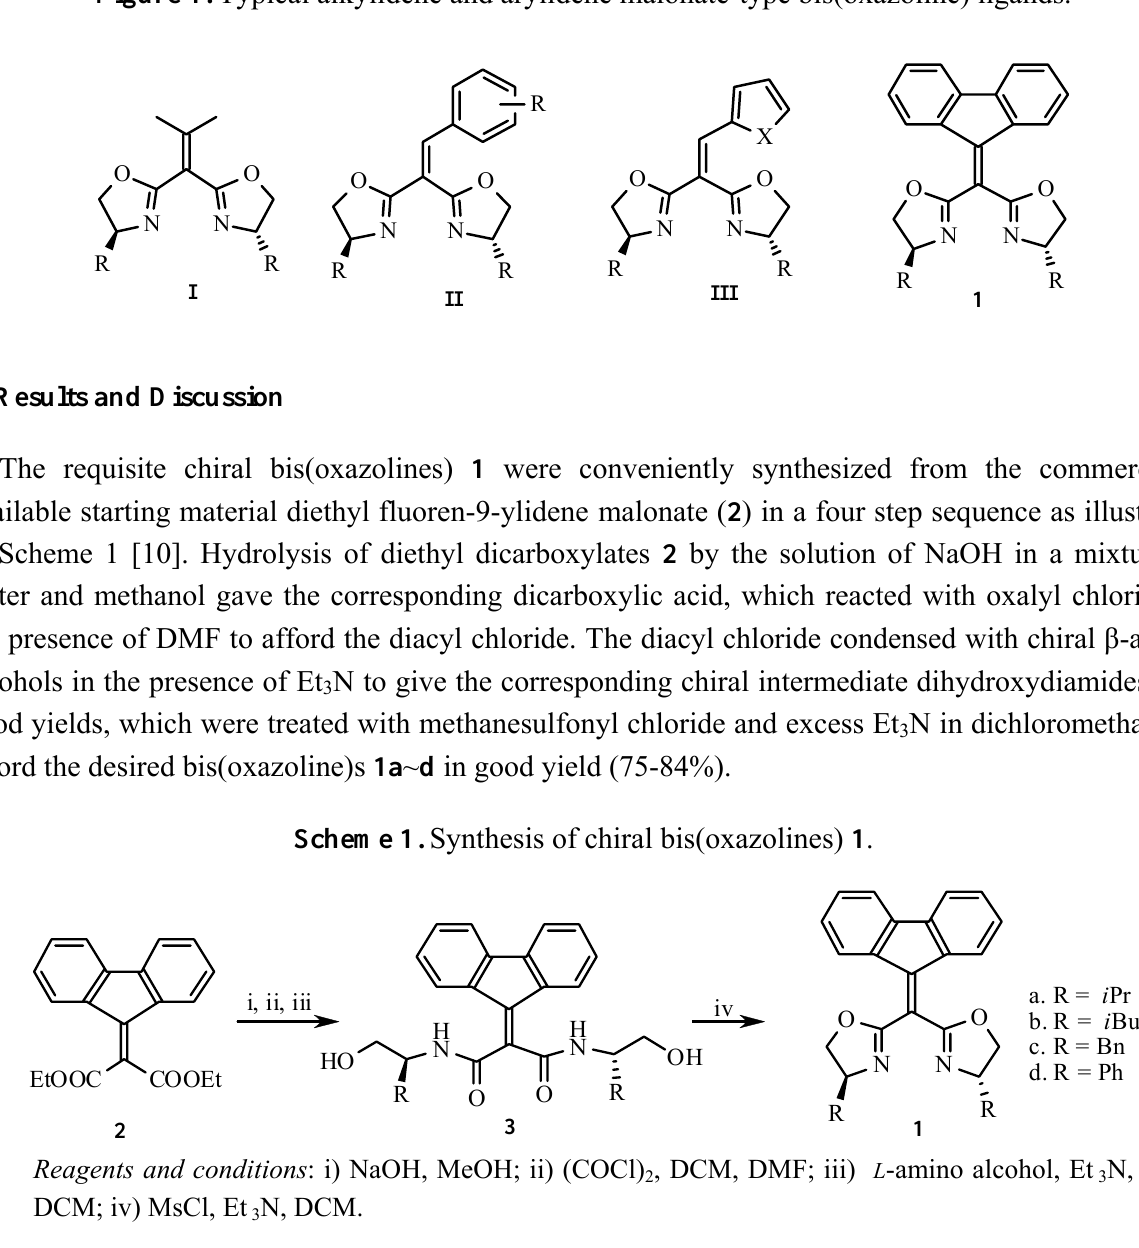
Figure 1. Typical alkylidene and arylidene malonate-type bis(oxazoline)